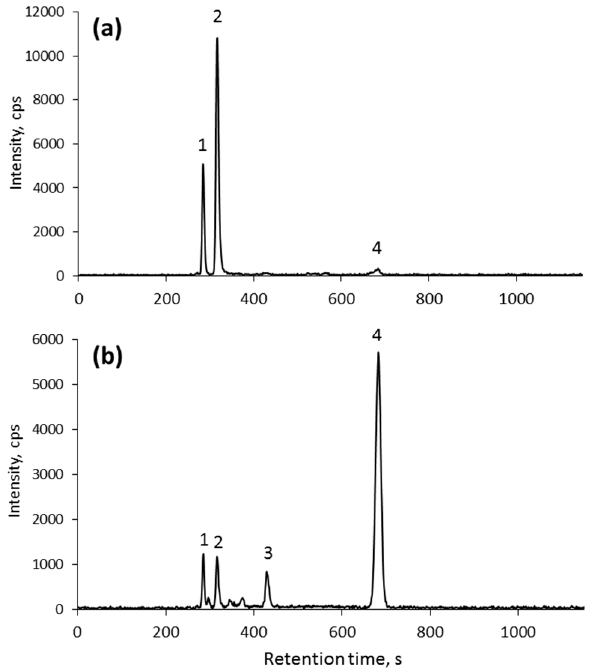
Figure 5. C8 RP HPLC-ICP MS chromatogram of the proteolytic digest of selenized yeast: ( a ) C. utilis ; and ( b ) CRM SELM-1. Identification of the species based on spiking with standards of: (1) SeCys-CAM; (2) Se-CAM; (3) SeMet-CAM; and (4) SeMet.